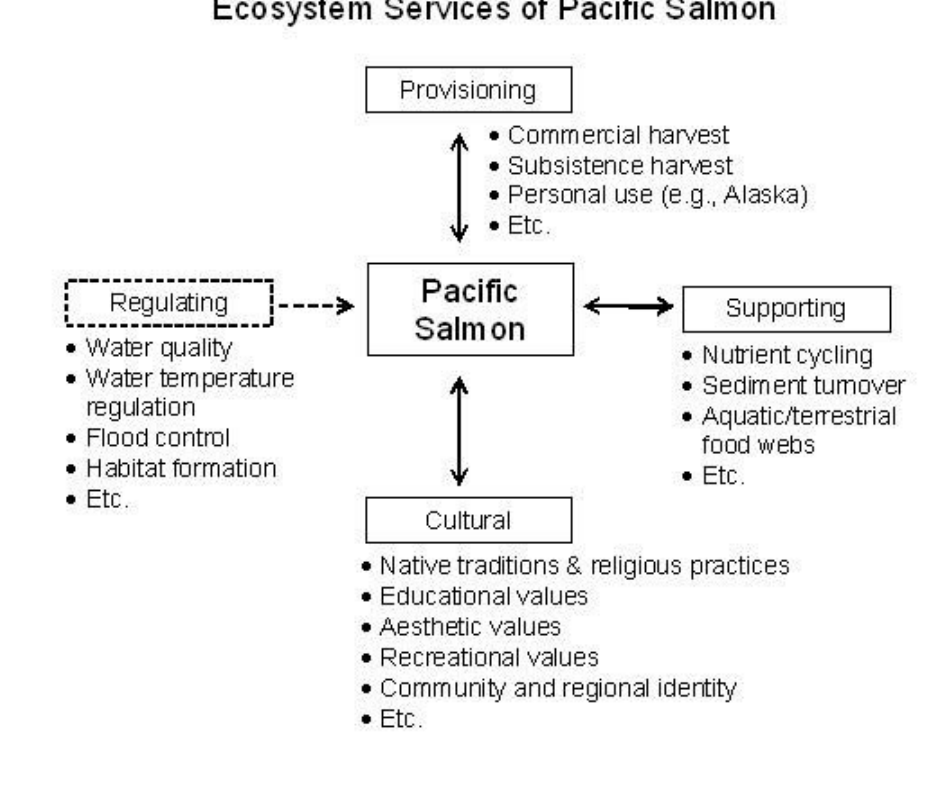
Fig. 2. Local salmon populations provide provisioning, cultural, and supporting ecosystem services that benefit people. These services often involve two-way interactions with feedbacks to salmon. Because salmon populations are sensitive to changes in environmental quality and habitat structure, they also are indicators of important regulating services that people derive from resilient salmon